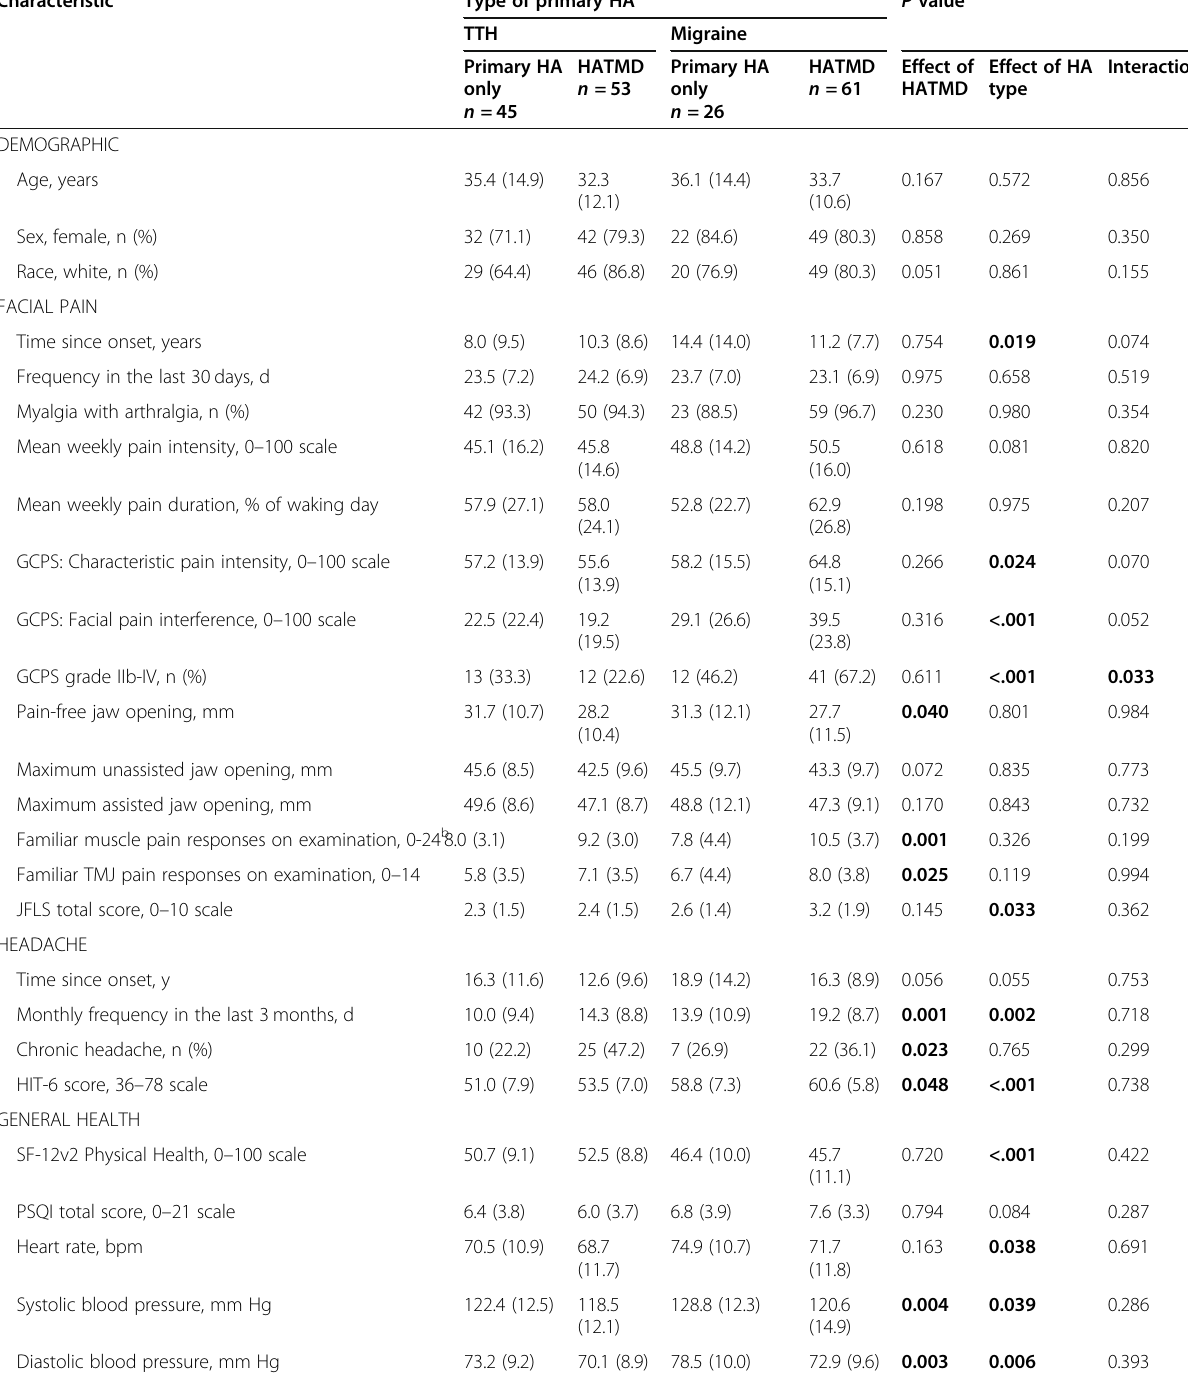
Table 1 Demographic and clinical characteristics in four groups classified according to primary headache and HATMD a